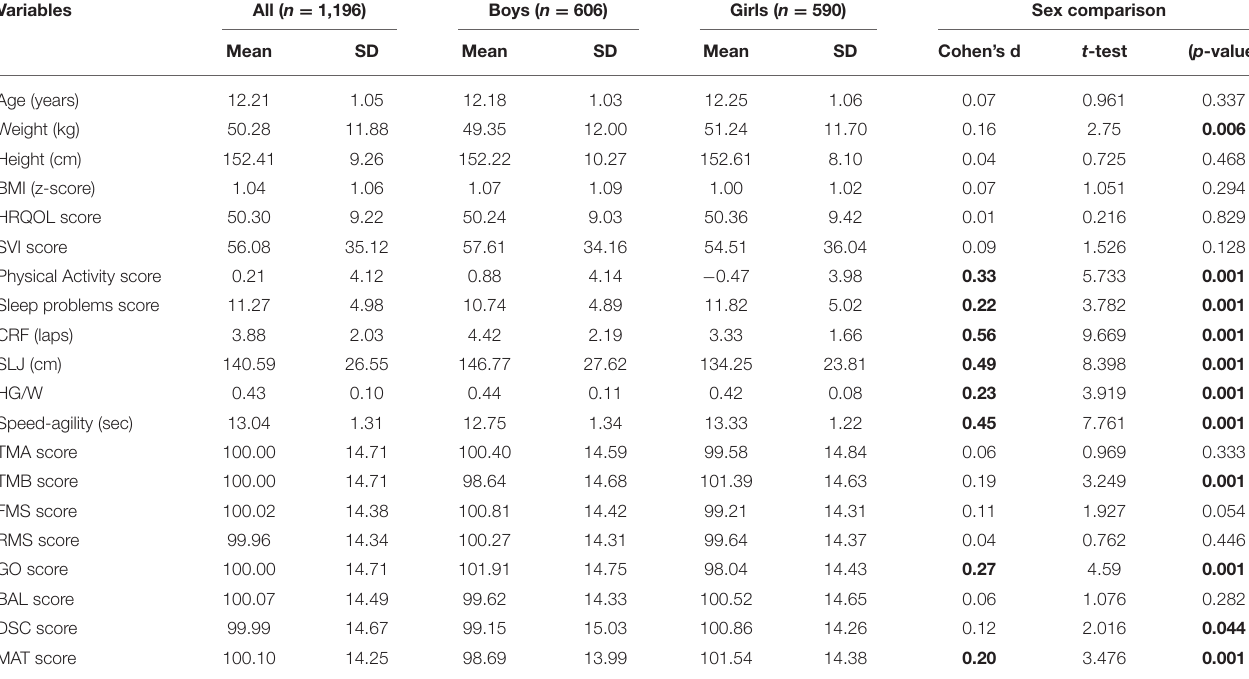
TABLE 1 | Descriptive adolescents’